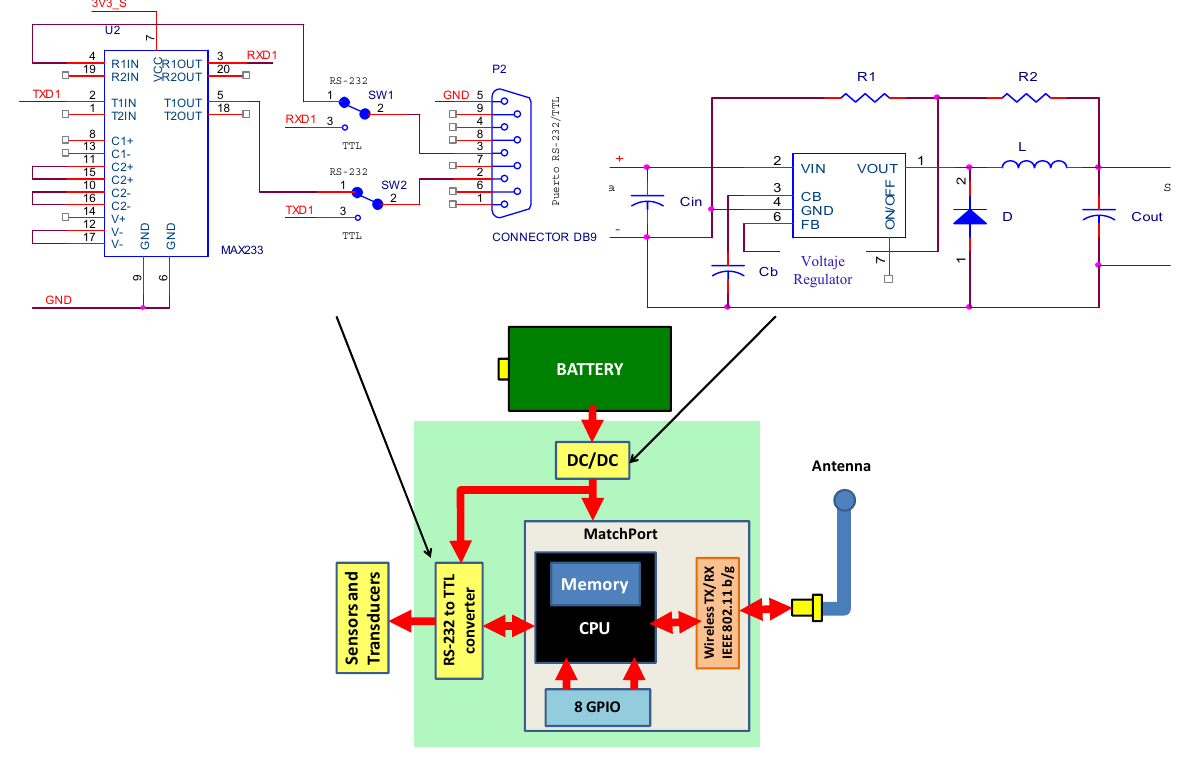
Figure 1. Block diagram of the underwater wireless sensor